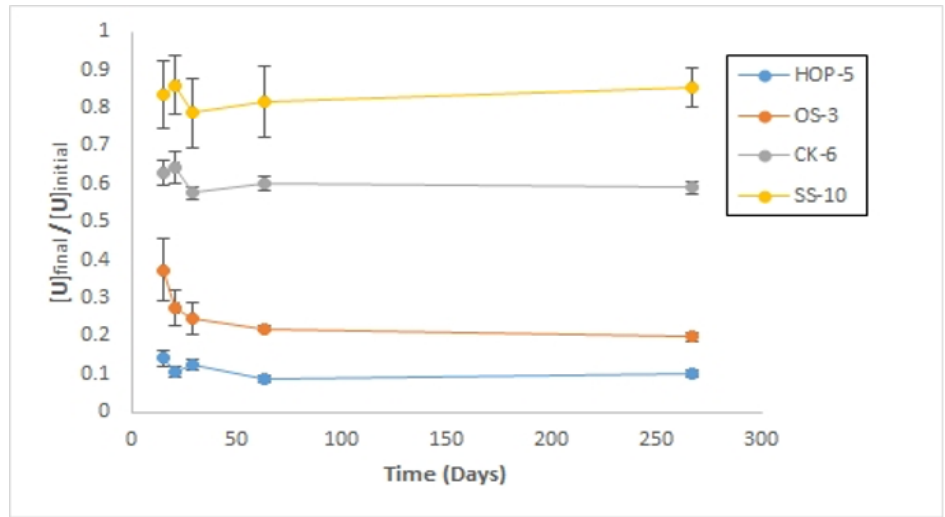
Figure G1: Results for the long-term, 9-month total duration sorption experiments on the HOP-5, CK-6, OS-3, and SS-10 rock samples. Concentrations are shown as a fraction of the initial uranium added to the batch experiments.